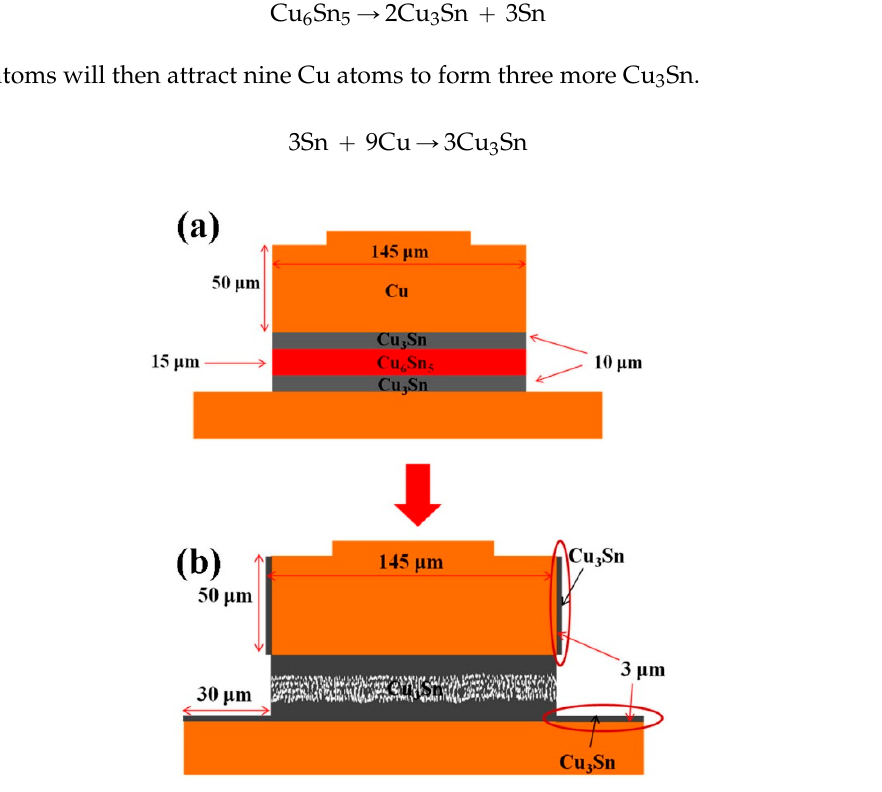
Figure 10. Schematic diagrams of transformation process at ( a ) early stage and ( b ) final stage in the electromigration tests.